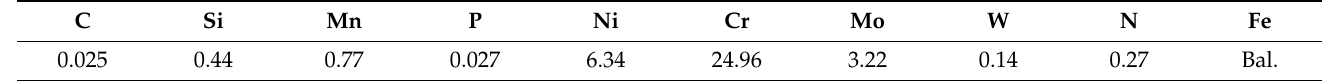
Table 3. Chemical composition of type 329J4L stainless steel